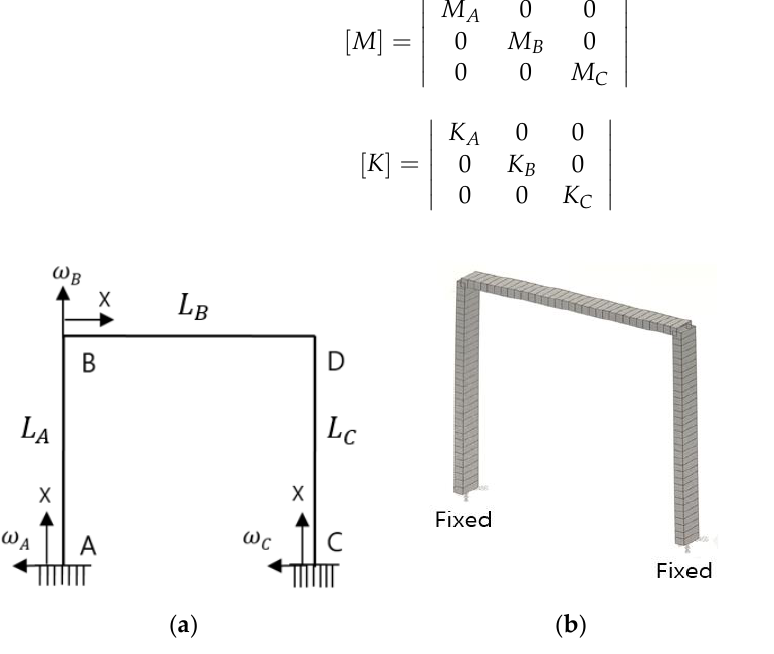
Figure 2. Structure model of three components type connected beam, ( a ) simplified model ( b ) FEA model.